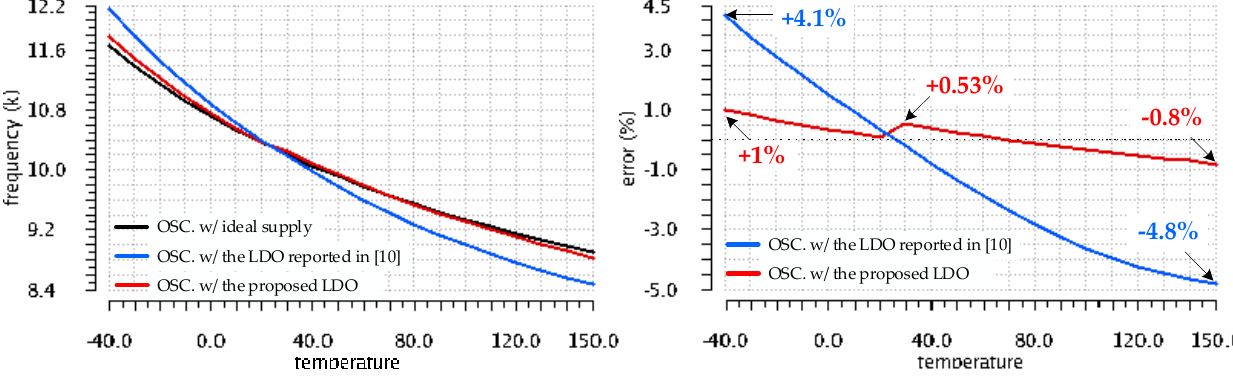
Figure 18. Variation over the temperature of the frequency values yielded by the oscillator for the three supply cases shown in Figure 15 and their deviation wrt. The ideal-supply case for the Monte Carlo run that yielded the worst-case V OS temperature drift for the proposed LDO, shown in Figure 3. Table 2 lists the relative error of frequencies provided by oscillators supplied by the two LDOs compared here, f1(T) and f2(T), with respect to the oscillator supplied by the